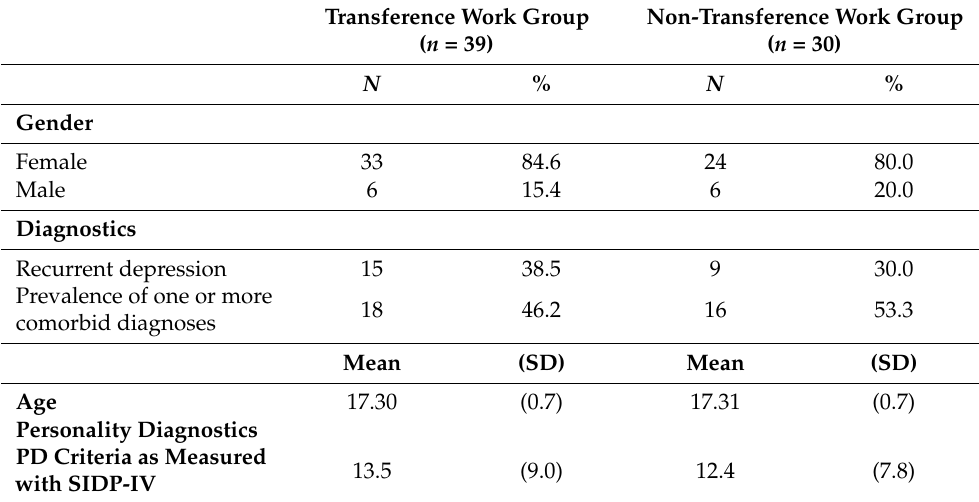
Table 1. Pre-treatment characteristics in 69 adolescents receiving 28 weeks of psychoanalytical psychotherapy with or without transference work